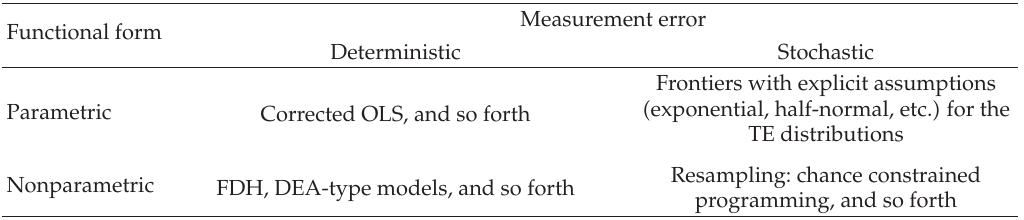
Table 1: Taxonomy of frontier methodologies (cid:5) 12 (cid:6)